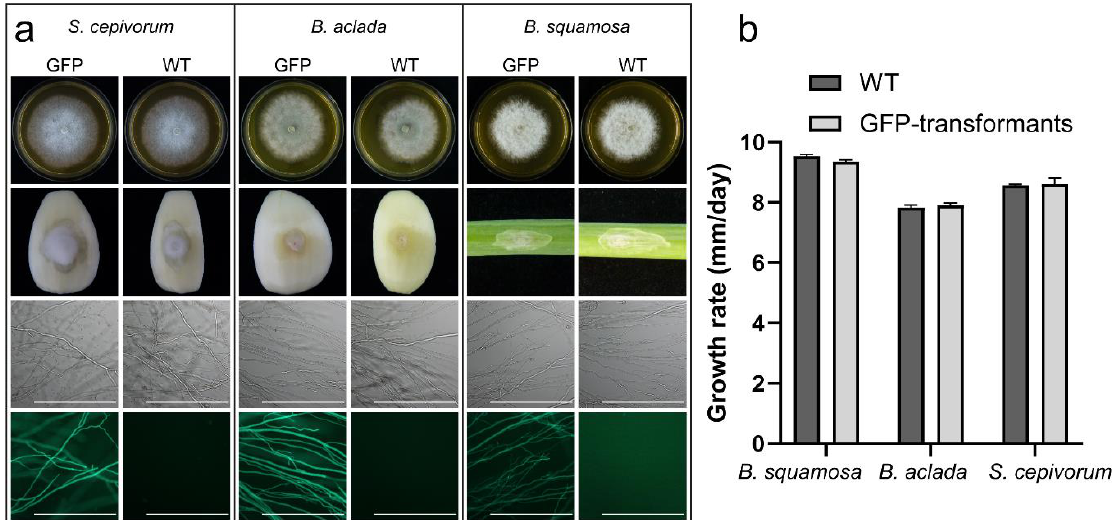
Figure 1. Evaluation of WT and GFP-expressing transformants of B. squamosa , B. aclada and S. cepivorum . ( a ) No differences were observed between WT and transformants based on morphology and growth on agar plates (first row) and pathogenicity on host tissue (second row), and only transformant strains are able to fluoresce (third and fourth row). Scale bar = 500 µm. ( b ) No difference was observed in growth rate between WT and transformants (unpaired t -test, p > 0.05, error bars representing standard error).